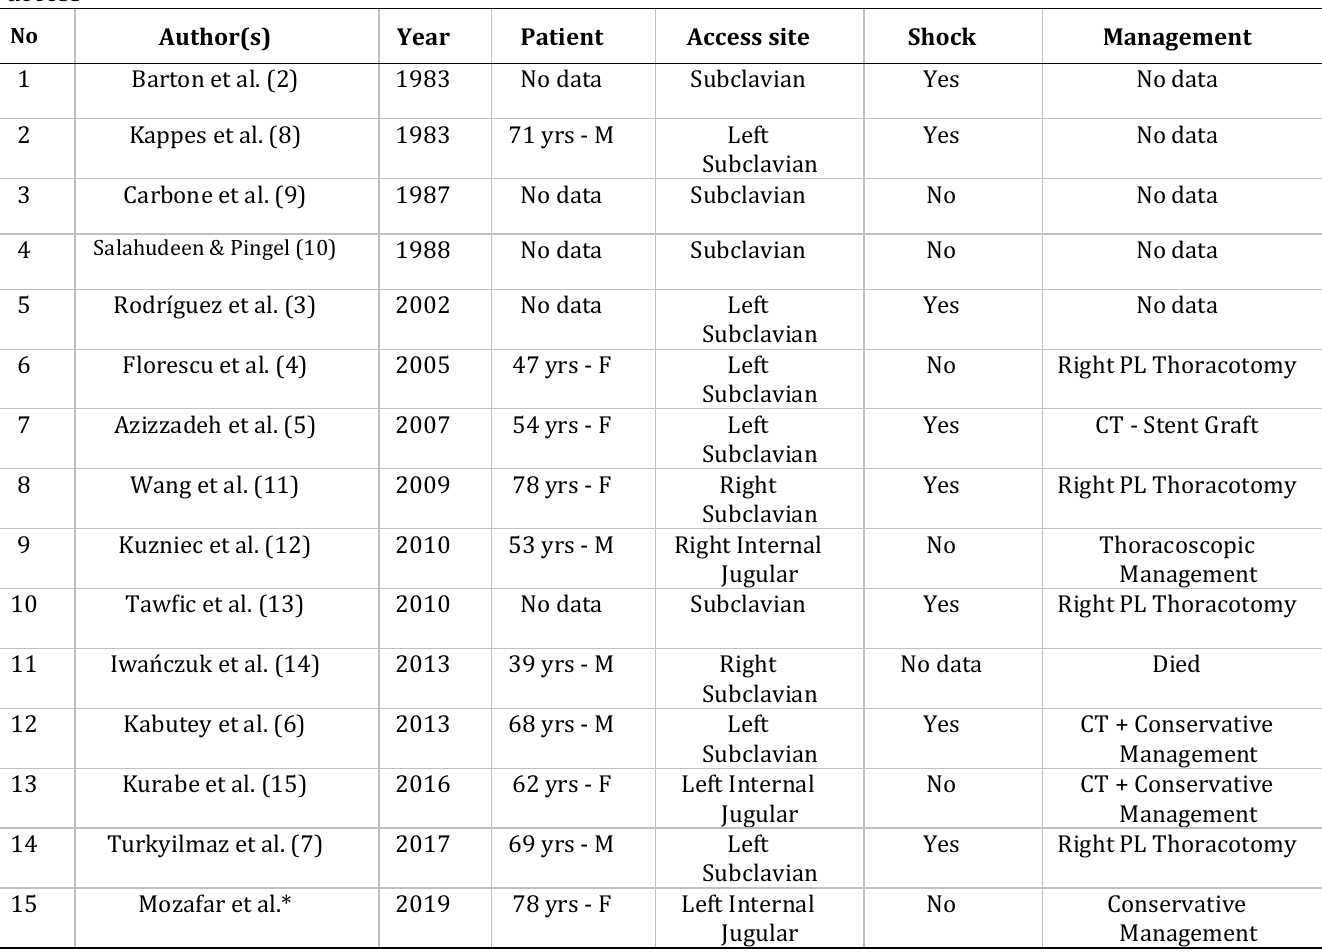
Table 1: Reported cases of iatrogenic superior vena cava (SVC) injuries during catheterization for hemodialysis